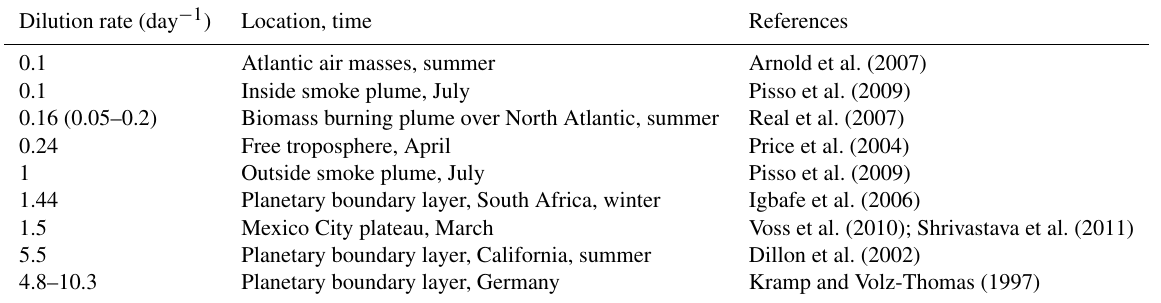
Table 4. Dilution rates in the